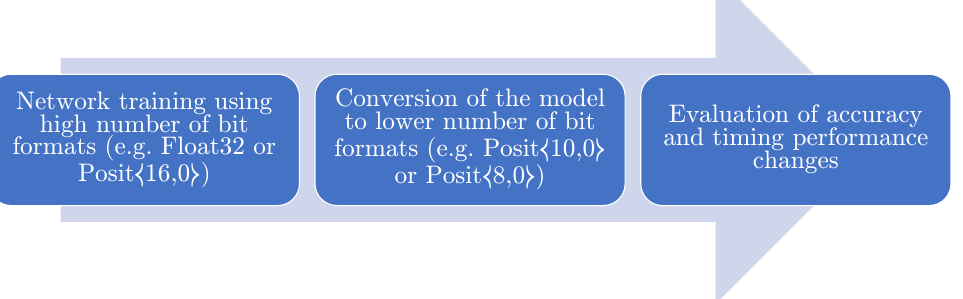
Figure 9. Flowchart for the proposed method: models are trained using formats with high bit count like Float32 or, in the future, Posit (cid:104) 16,0 (cid:105) . The models obtained this way are then converted to formats with lower bit count (e.g., Posit (cid:104) 8,0 (cid:105) ) to increase space efficiency and